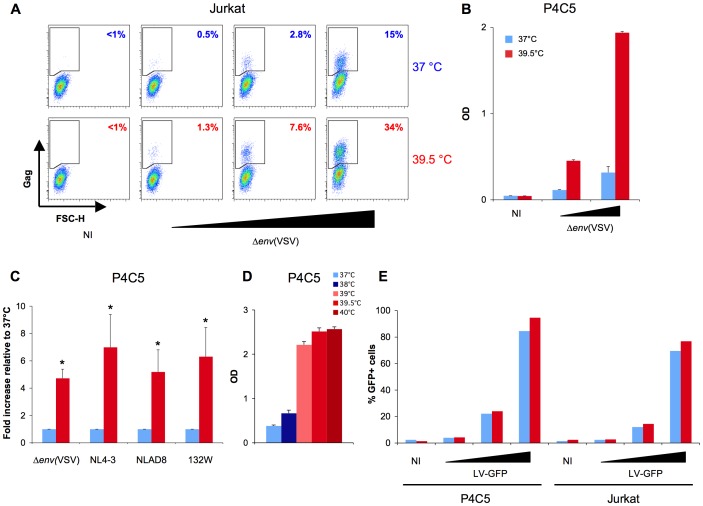
Hyperthermia increases infection with single-cycle HIV-1 but not with a GFP lentivector.A: Infection of Jurkat cells with single-cycle HIV. One representative experiment is shown. Cells were infected with 5, 20, or 100 ng Gag p24 of Δenv(VSV)/mL/106 cells for 2 hours at 37°C or 39.5°C, washed, and grown at 37°C or 39.5°C. Gag levels were assessed by flow cytometry at 24 hours p.i. B: Infection of P4C5 cells with single-cycle HIV. One representative experiment is shown. 8×104 P4C5 cells were plated in 96-well plates. Cells were infected in triplicates with 1 or 5 ng Gag p24 of Δenv(VSV) and grown at 37°C or 39.5°C. Infection was assessed 36 hours p.i. by measuring β-Galactosidase activity (570 nm OD). C: Mean ± SD of 4 independent experiments. P4C5 cells were infected with 1 ng Gag p24 of the indicated HIV strains. Statistical significance was assessed by the Mann-Withney test. p<0.05(*). D: Infection of P4C5 cells at different temperatures. One of two representative experiments is shown. Data are mean ± SD of triplicates. Using the same protocol as in B, cells were infected with 5 ng Gag p24 of NL4-3 and grown at the indicated temperatures. E: Transduction of P4C5 and Jurkat cells with a GFP expressing lentivector (LV-GFP). One of three representative experiments is shown. P4C5 or Jurkat cells were transduced with 1, 10 or 100 ng Gag p24/mL/106 cells of LV-GFP. GFP levels were measured 24 hours later by flow cytometry.